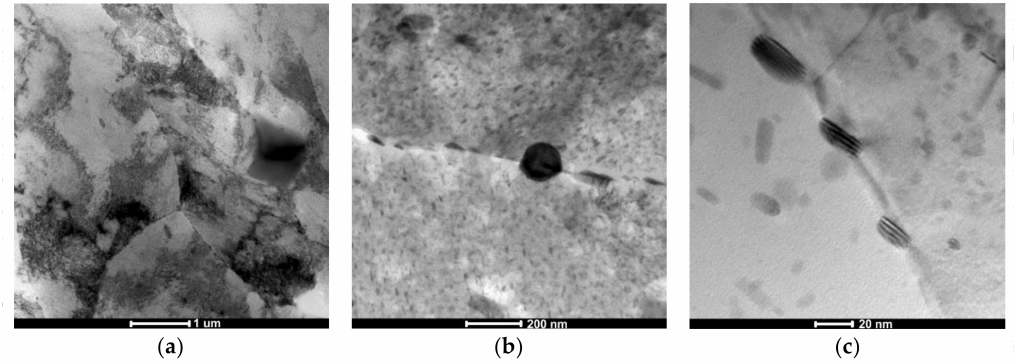
Figure 8. The AlZn6Mg0.8Zr alloy after LTTT with 30% deformation: (a) cellular dislocation structure;